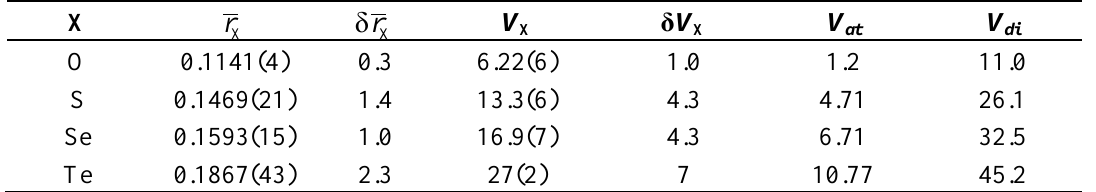
Table 2. Spherically-averaged radii and volumes of chalcogen atoms and ions with radii given in nm, volumes in 10 −3 nm 3 and relative errors and δ V parenthesis give the standard deviations for the last digit(s) of the preceding value.